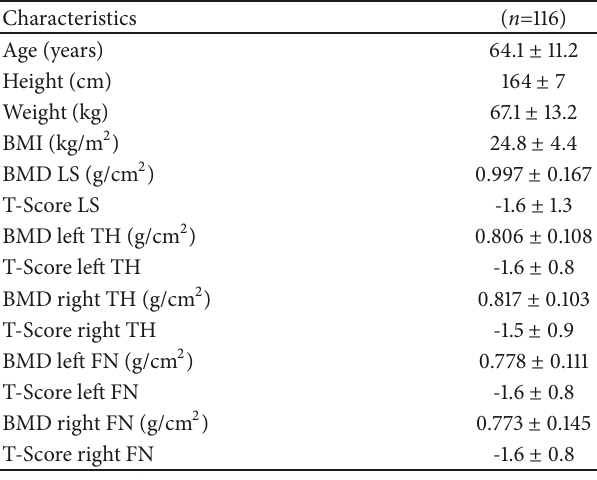
Table 1: Baseline characteristics of the